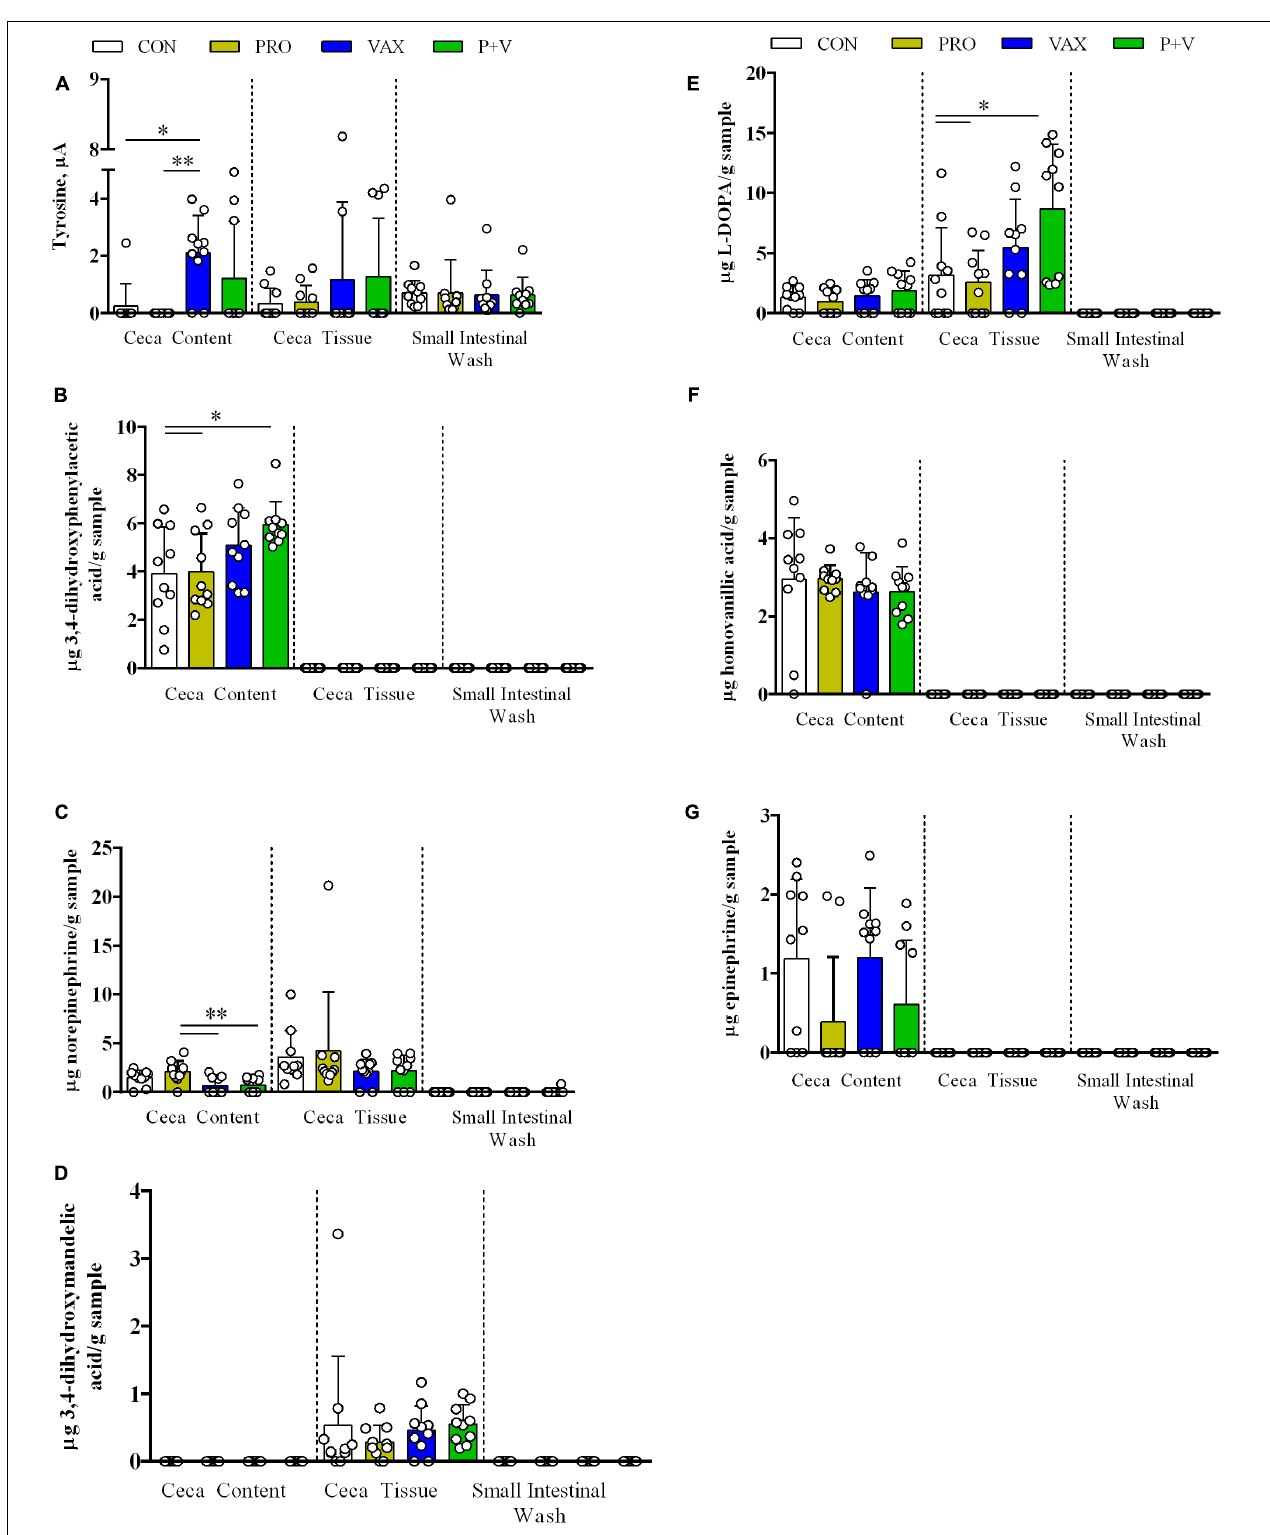
FIGURE 3 | Detection of catecholamine metabolites (A) tyrosine, (B) DOPAC, (C) norepinephrine, (D) DHMA, (E) L-DOPA, (F) HVA, and (G) epinephrine in ceca content, ceca tissue, and small intestinal scrapings. Each dot represents an individual animal, bars represent mean ± standard deviation. ∗ P < 0.05; ∗∗ P < 0.01. White, CON; yellow, PRO; blue, VAX; green, P+V.